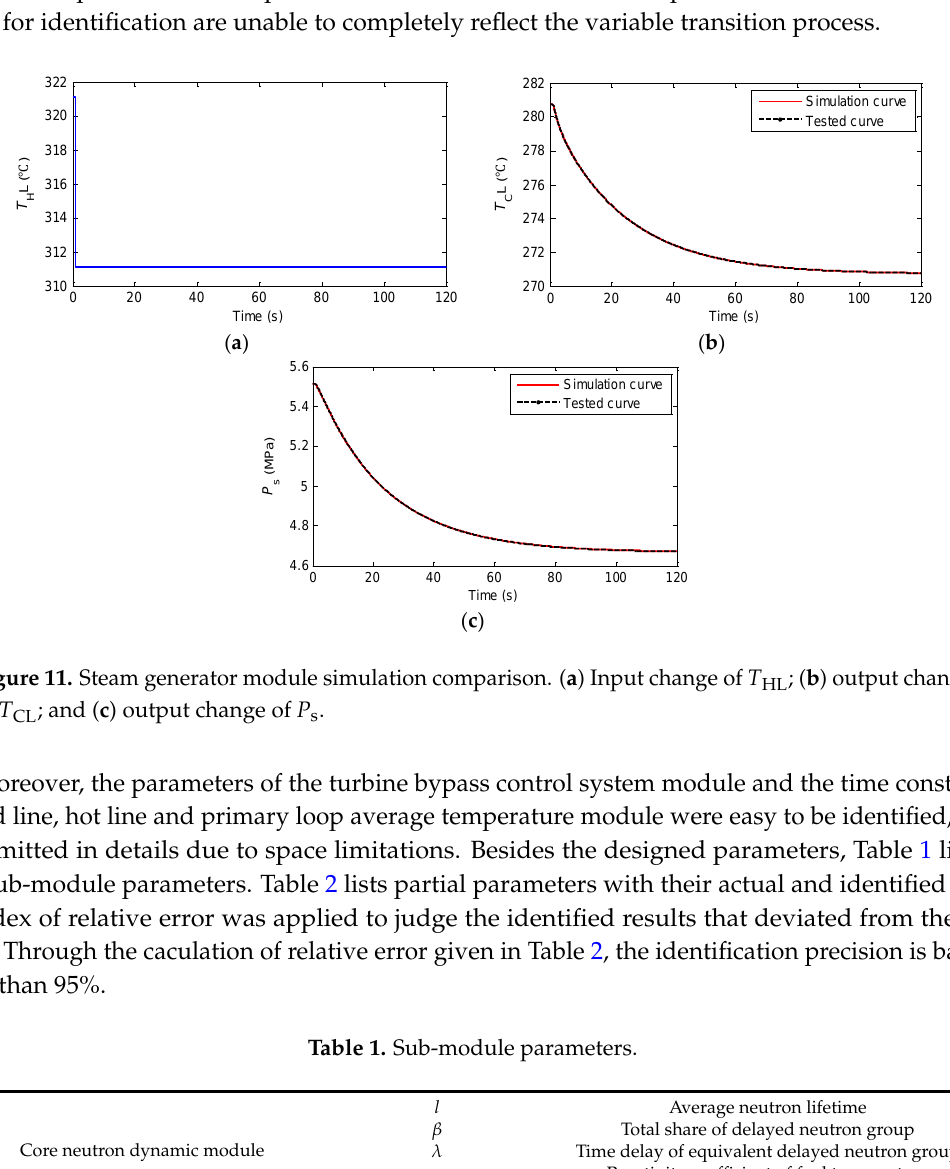
Table 1. Sub-module parameters.